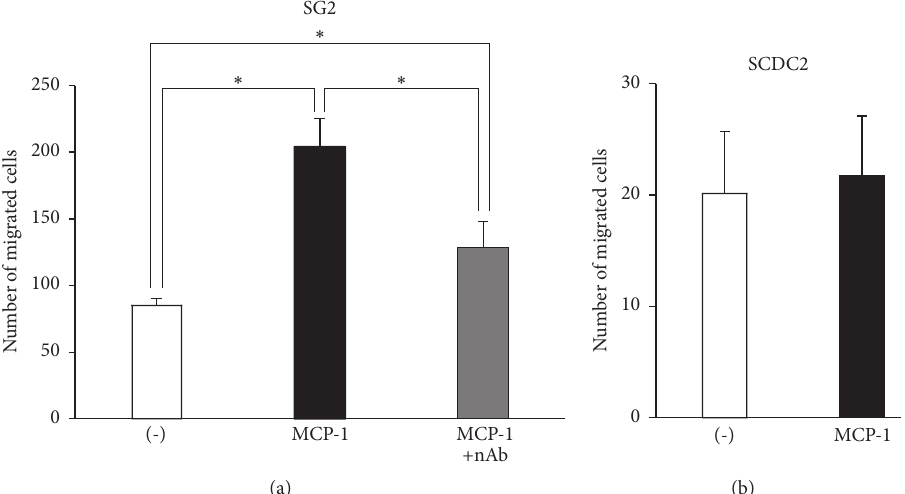
Figure 2: MCP-1 specifically induces the migration of SG2 cells rather than that of SCDC2 cells. Transwell migration assay for SG-2 cells (a) and SCDC2 cells (b) by stimulation with 10ng/mL of MCP-1. Anti-MCP-1 neutralizing antibody (nAb) was also added with MCP-1 for migration in SG2 cells (a). The cells that migrated to the underside of the membrane were labeled with DAPI and counted under a fluorescence microscope in five high-power fields. Data are presented as the mean ± standard deviation. ∗ 𝑃 < 0.05 as compared with the unstimulated control (-) for each cell